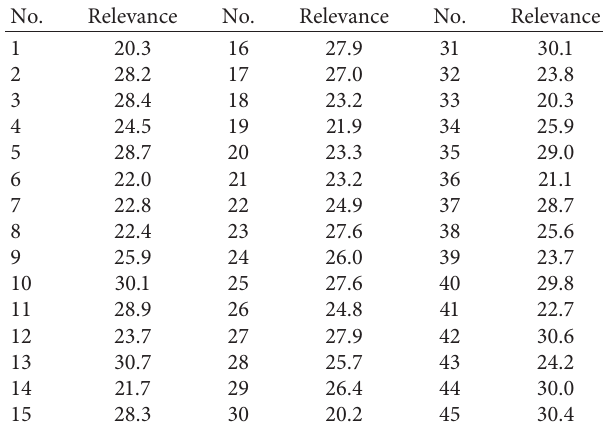
Figure 7: Statistical diagram of the relevance between interest rate reform and GDP growth. Table 1: Relevance between interest rate reform and GDP growth. No. Relevance